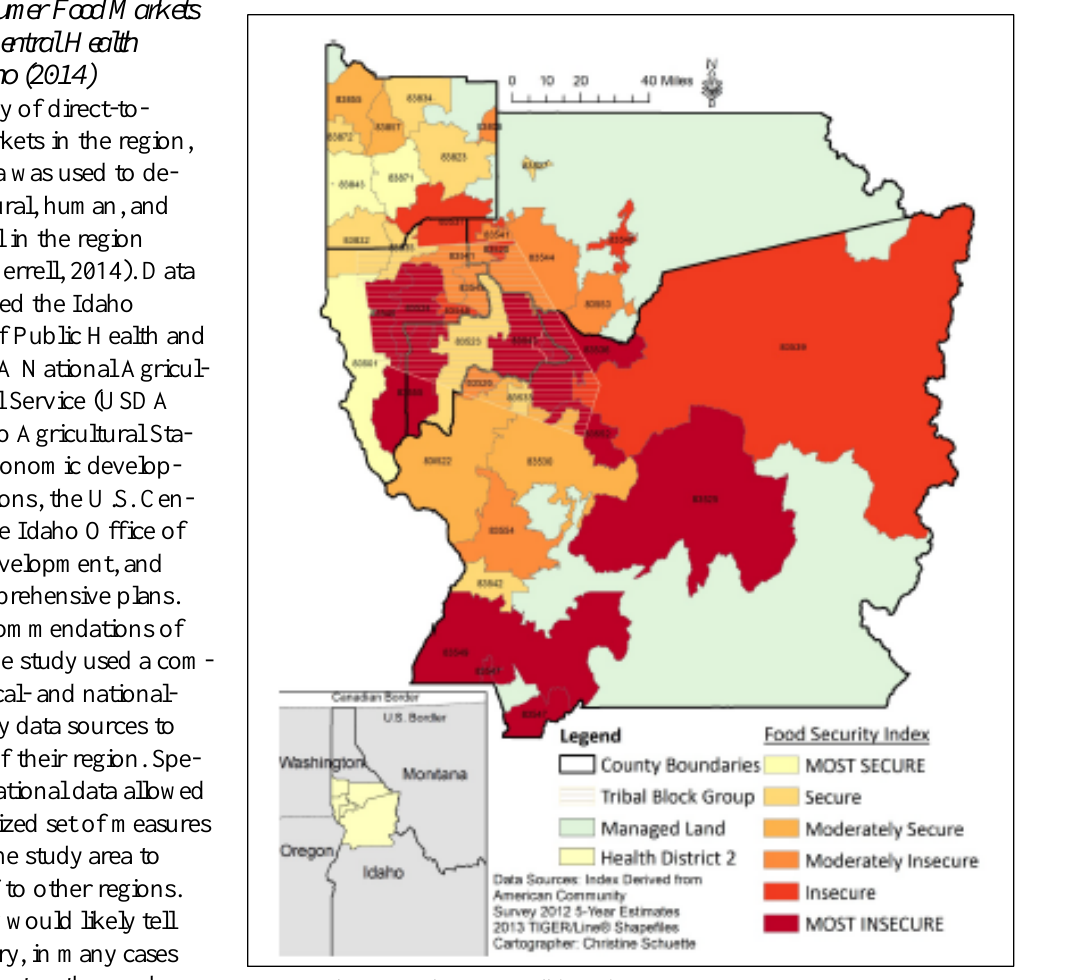
Source: Schuette, Laninga & Merrell